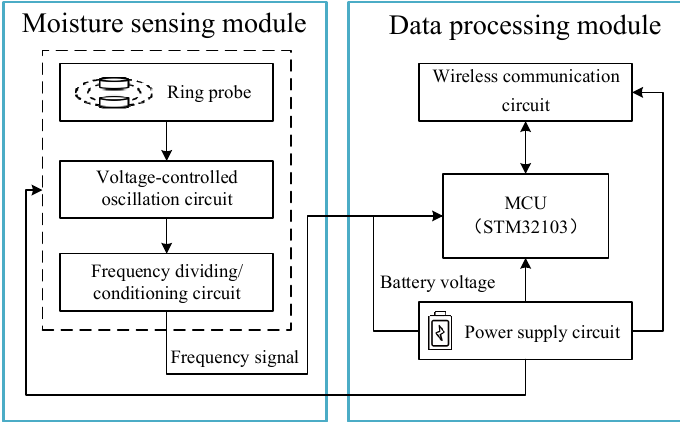
Figure 5. Overall hardware circuit diagram.